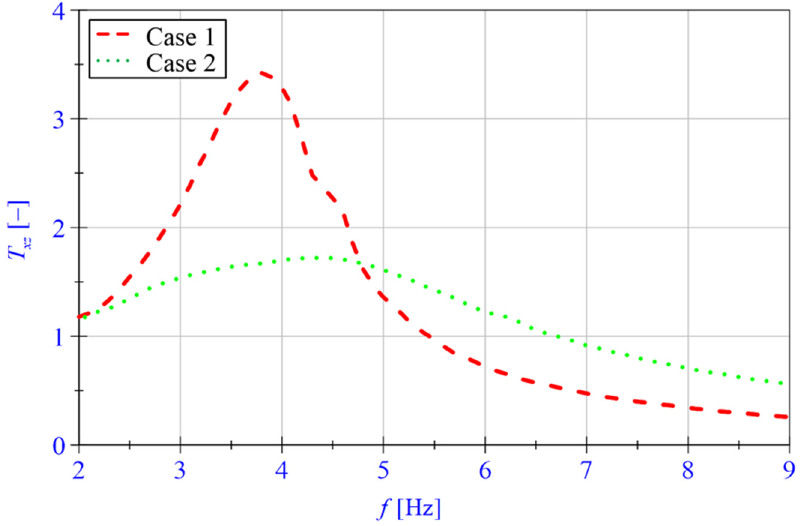
Figure 4. Displacement transmissibility T xz vs. frequency f The average power provided by the shaker (cid:1842) (cid:3046) ((cid:1858)) and dissipated in the MR damper 6. The graphs refer to Case 2 with three displacement (cid:1878) frequency values. Taking into ac-